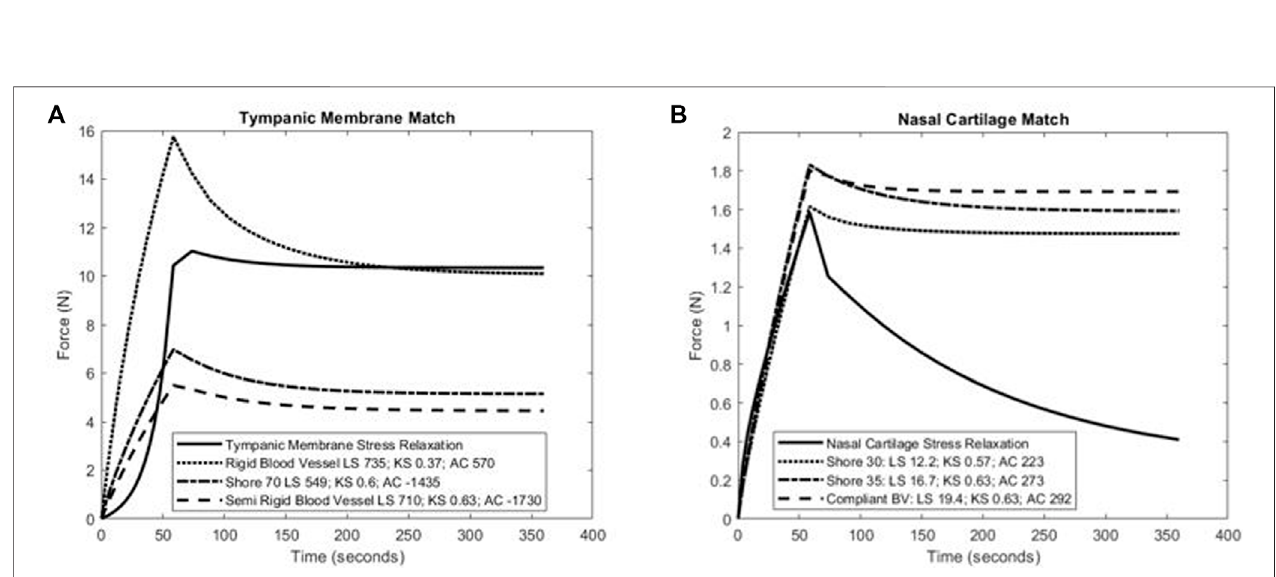
FIGURE 7 | Calculation of least-square difference (LS), Kolmorogorov – Smirnov statistic (KS), and differences in area under the force-time curve between three closest J750 materials and (A) human tympanic membrane nonlinear viscoelastic properties (Motallebzadeh et al., 2013) and (B) human nasal cartilage nonlinear viscoelastic properties (Chang et al., 2020). Note that lower magnitude values of each parameter indicate a J750 parameter that more closely matches native tissue behavior.ResultssuggestthateithertheShore70orRigidBloodVesselmaterialbestmatchthetympanicmembrane (A) ,whiletheShore30materialbestmatches human nasal cartilage (B)